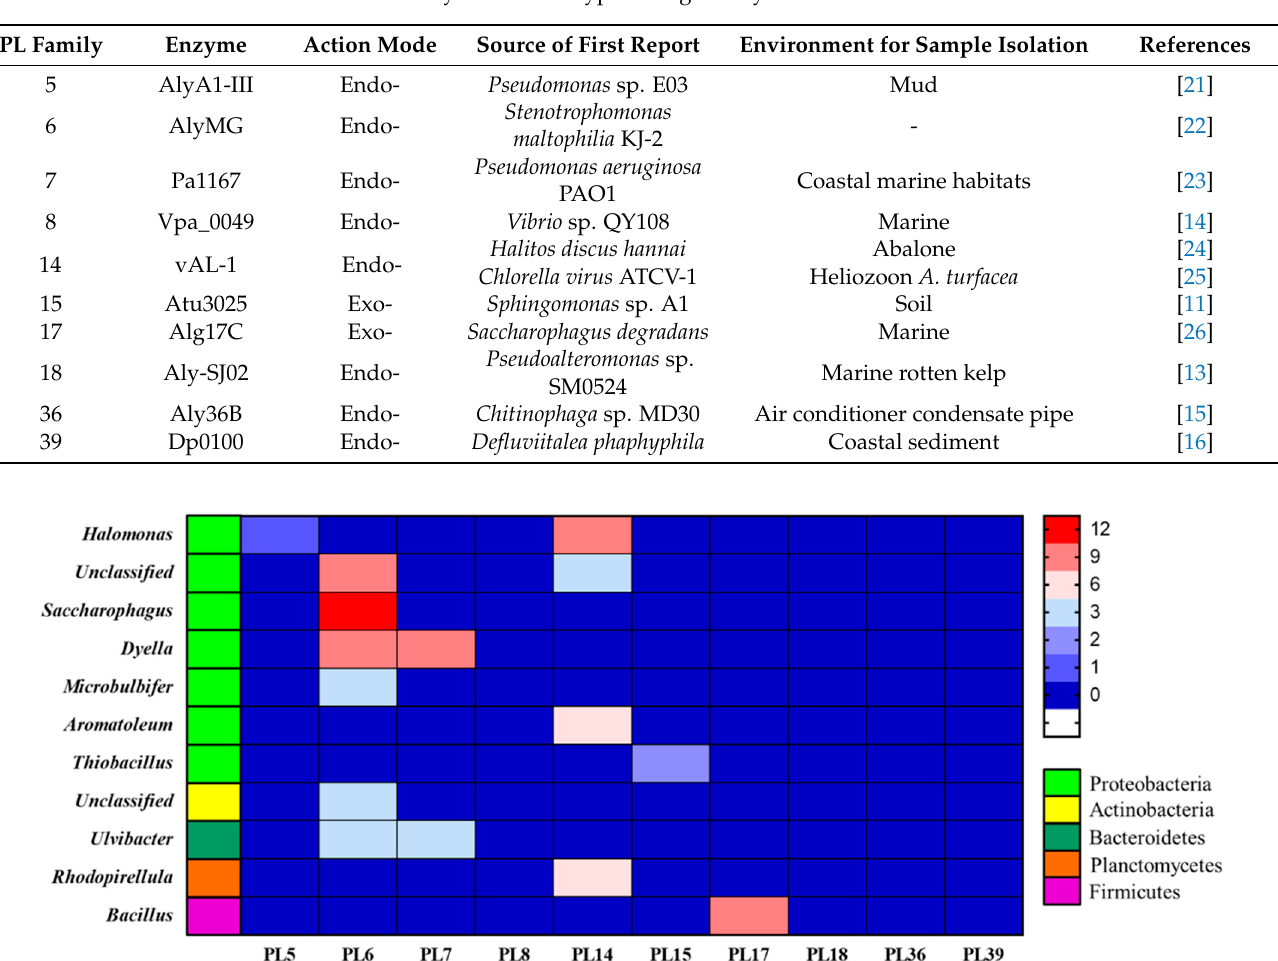
PL Family Enzyme Action Mode